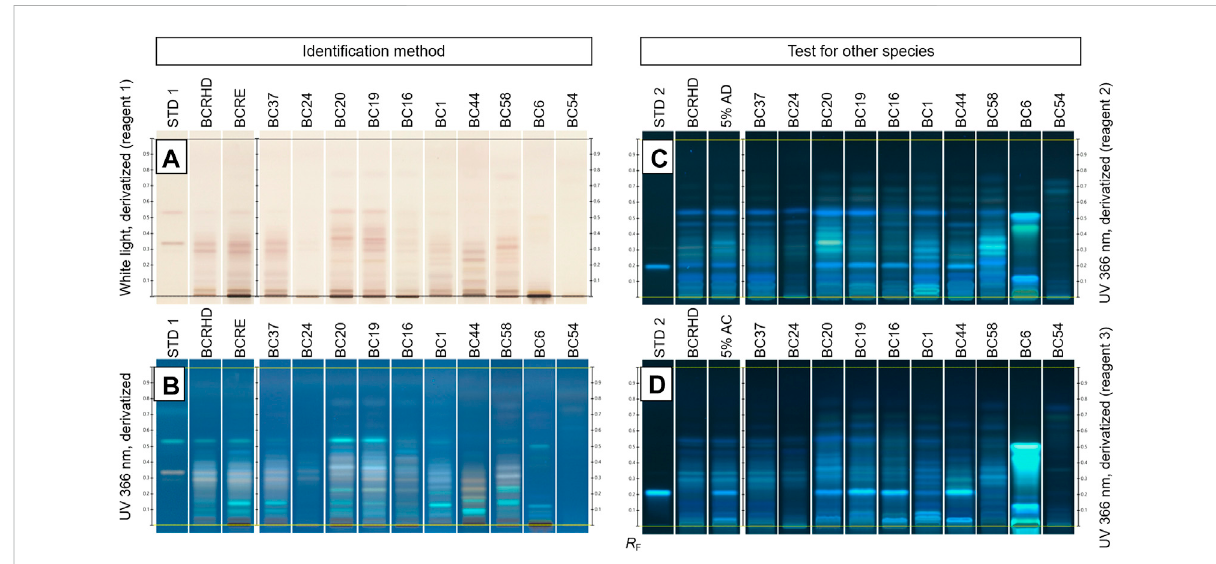
FIGURE 7 HPTLC fi ngerprint of 11 black cohosh products and herbal drugs/herbal preparations. STD1: actein and isoferulic acid (increasing R F ); STD2: cimifugin; RBCR: reference black cohosh root; RBCE: reference black cohosh root extract; 5% AD: Actaea racemosa mixed with 5% of A. dahurica